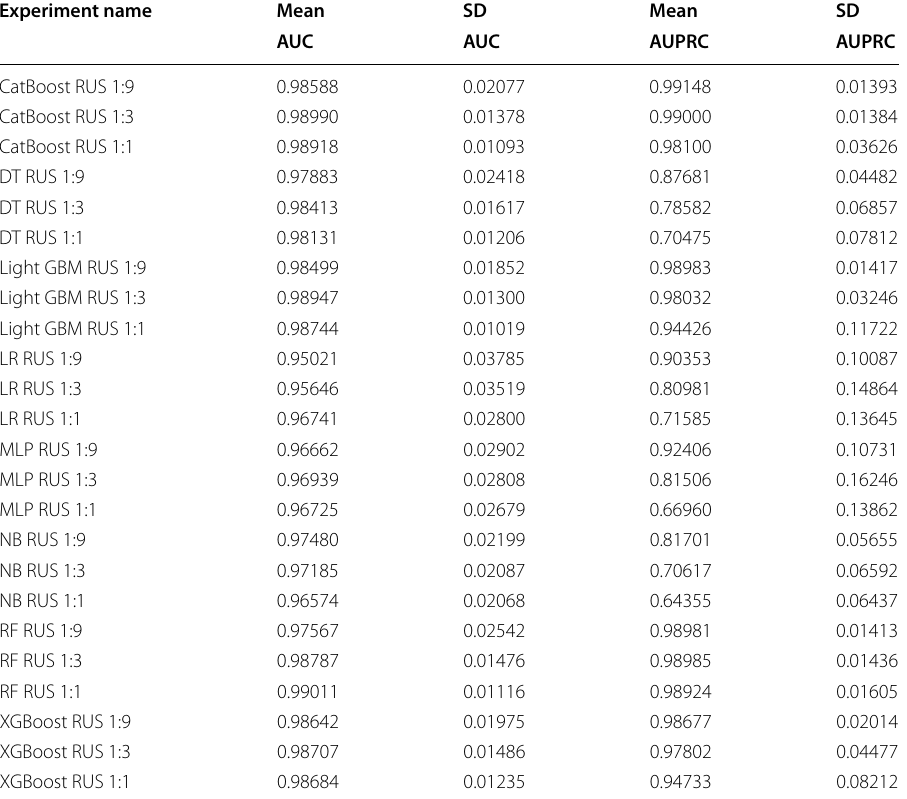
Table 18 Classification results for the data exfiltration dataset with sampling and default hyperparameters experiments; mean and standard deviations of AUC and AUPRC, (10 iterations of 5-fold